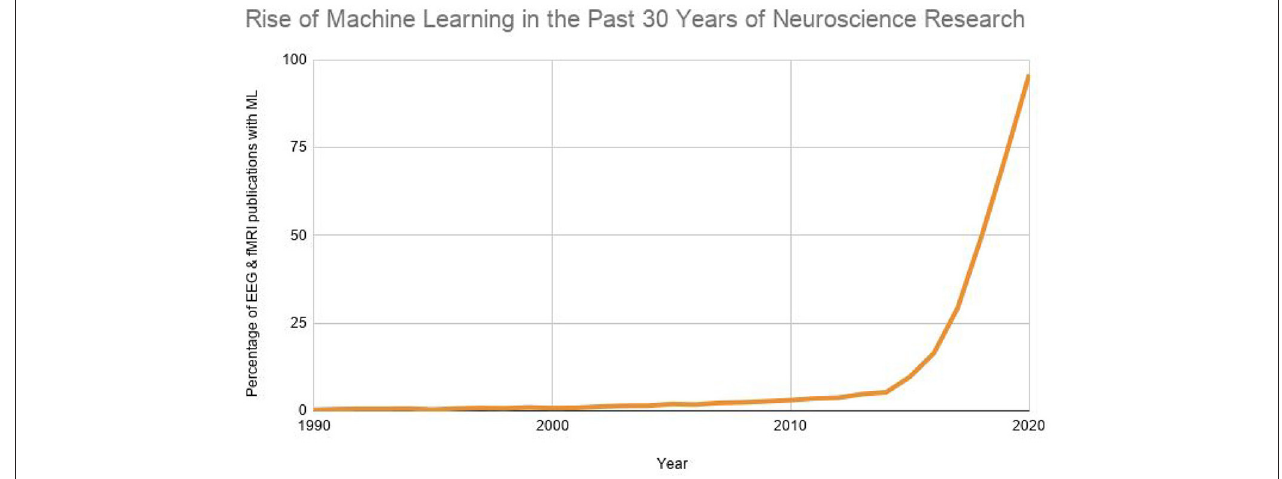
FIGURE 6 | Here we plot the proportion of neuroscience papers that have used machine learning over the last three decades. That is, we calculate the number of papers involving both neuroscience and machine learning, normalized by the total number of neuroscience papers. Neuroscience papers were identified using a search for “EEG + fMRI” on semantic scholar. Papers involving neuroscience and machine learning were identified with a search for “machine learning” and “EEG + fMRI” on semantic scholar.